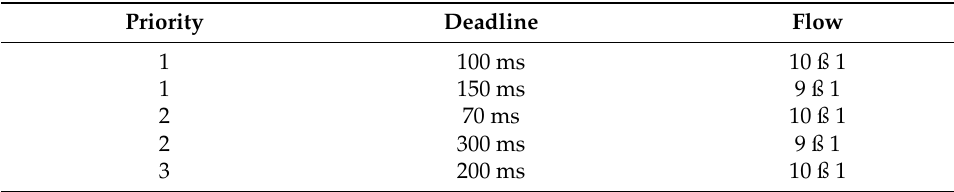
Table 3. Data traffic